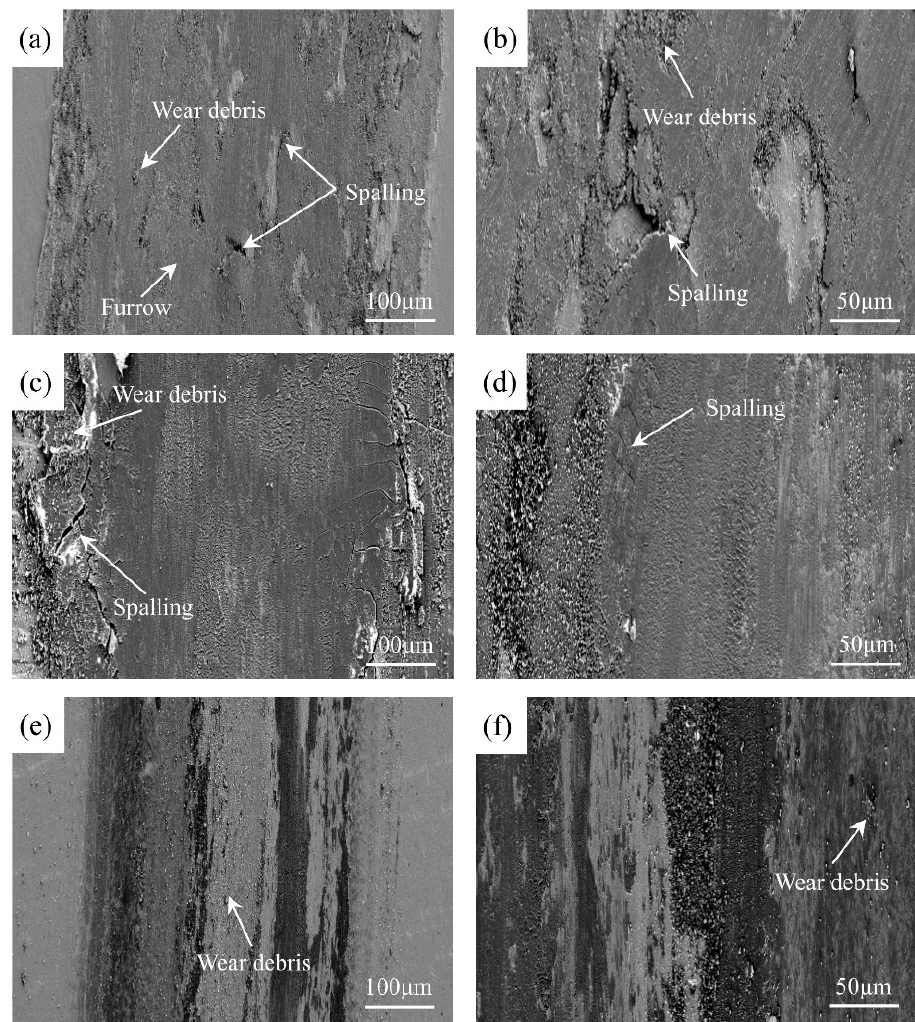
Figure 14. Wear trajectory topography: ( a,b ) substrate; ( c,d ) GF coating; ( e,f ) HF coating.